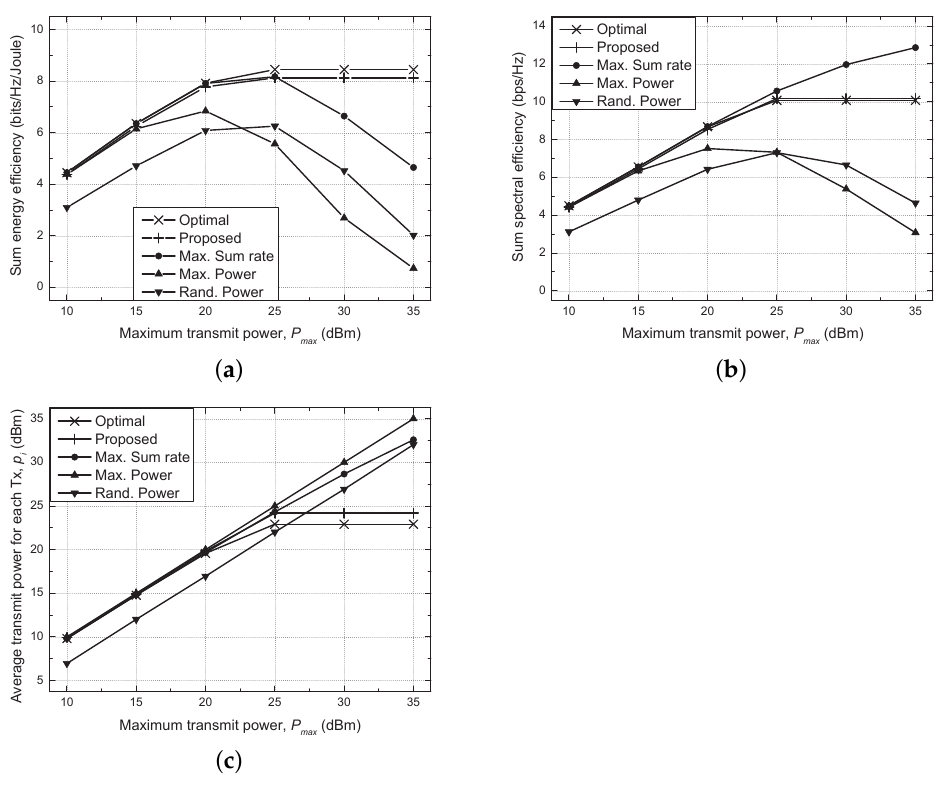
Figure 3. Performance comparison versus the maximum transmit power ( P max ). ( a ) Sum energy efficiency vs. P max . ( b ) Sum spectral efficiency vs. P max . ( c ) Average transmit power vs. P max